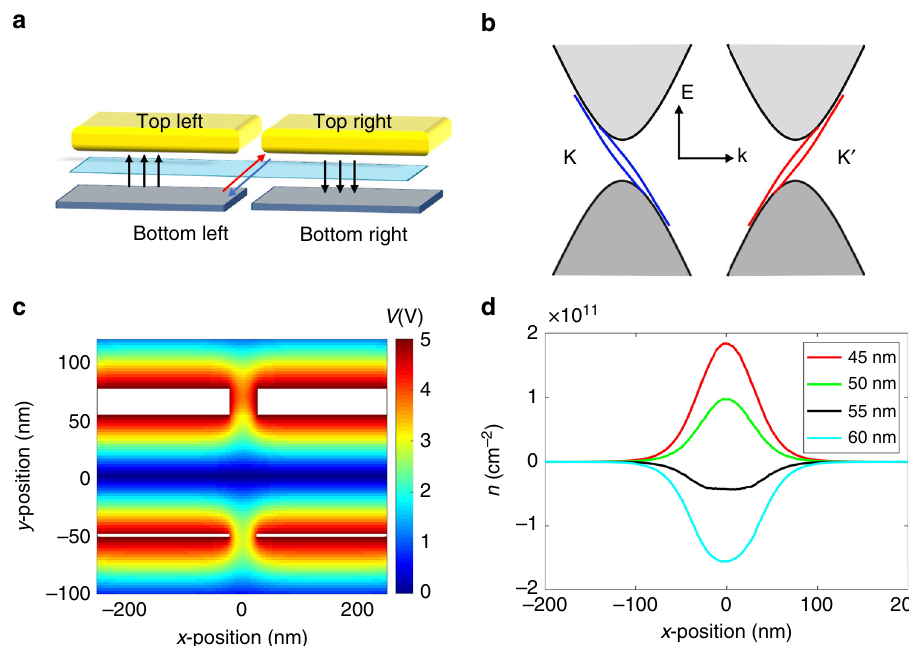
Fig. 1 Schematics of device geometry and electrostatic modeling. a Schematic of the dual-split gated device. Two pair of gates tune independently the displacement fi eld and charge density in the left and right part. b Schematic of valley-polarized channels K and K ’ in each Dirac cones, with opposite group velocity. c Cross-section view of electrical potential from electrostatic modeling. The horizontal axis corresponds to x direction position and vertical axis corresponds to z direction position. d Distribution of residual charges density n in bilayer graphene in an asymmetric device. Different spacing parameters of top gates are tested to minimize the residual charge density when bottom gates spacing is constant 50